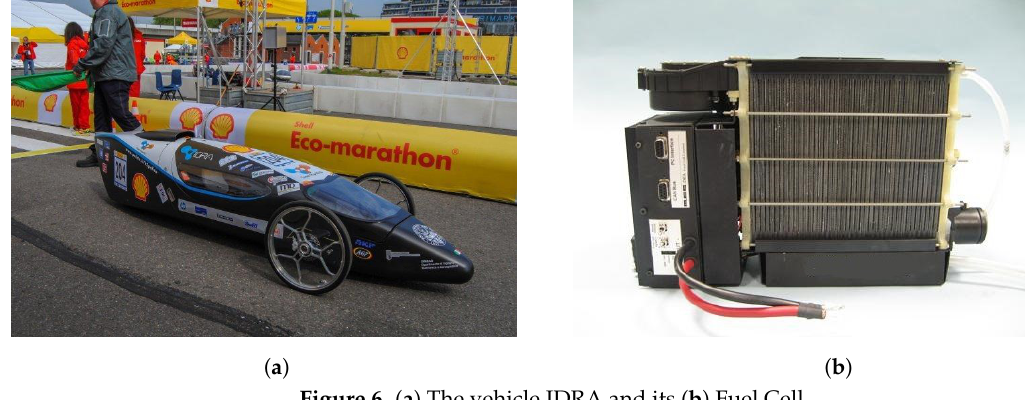
Figure 6. ( a ) The vehicle IDRA and its ( b ) Fuel